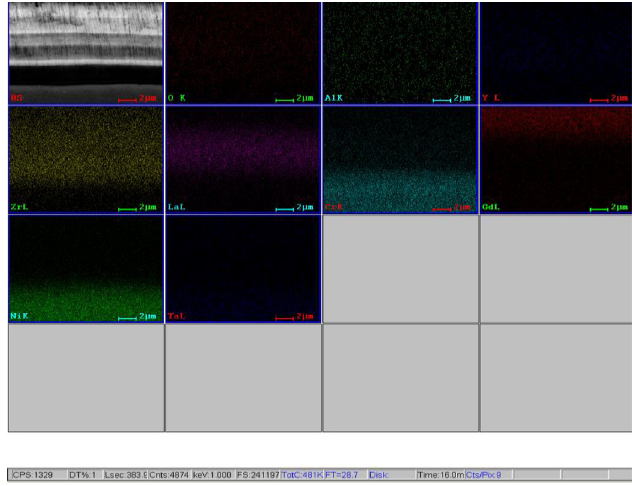
Fig. 2. EDS elemental maps of the fi lms deposited by EB-PVD on a Ni base super alloy support manufactured by 3D printing.